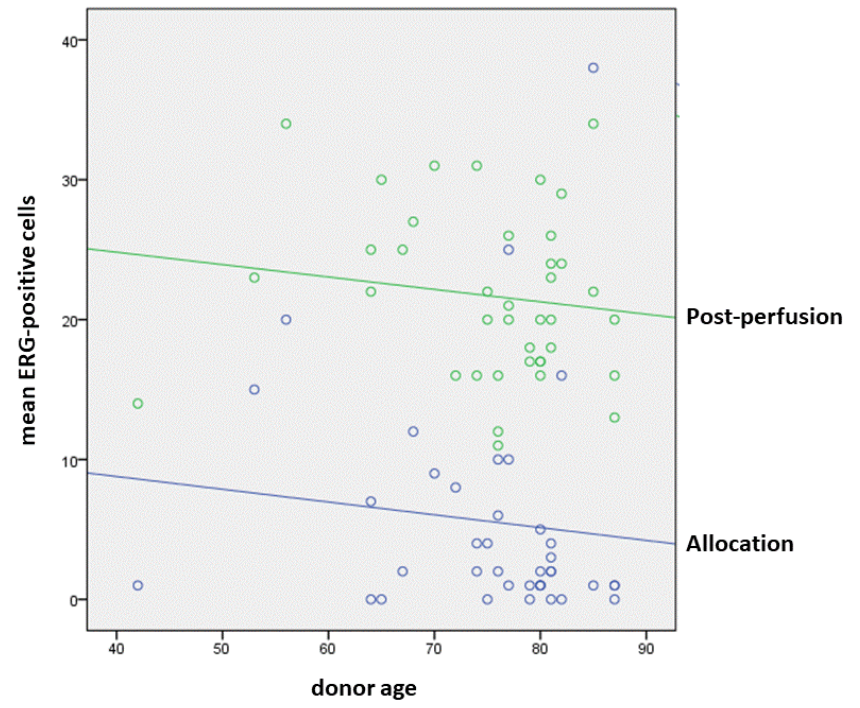
Figure 2. In post-perfusion biopsies (green dots and line), ERG significantly increased compared to allocation biopsies (blue dots and line), but in both groups, an inverse correlation was observed between ERG immunoreactivity and donor age.